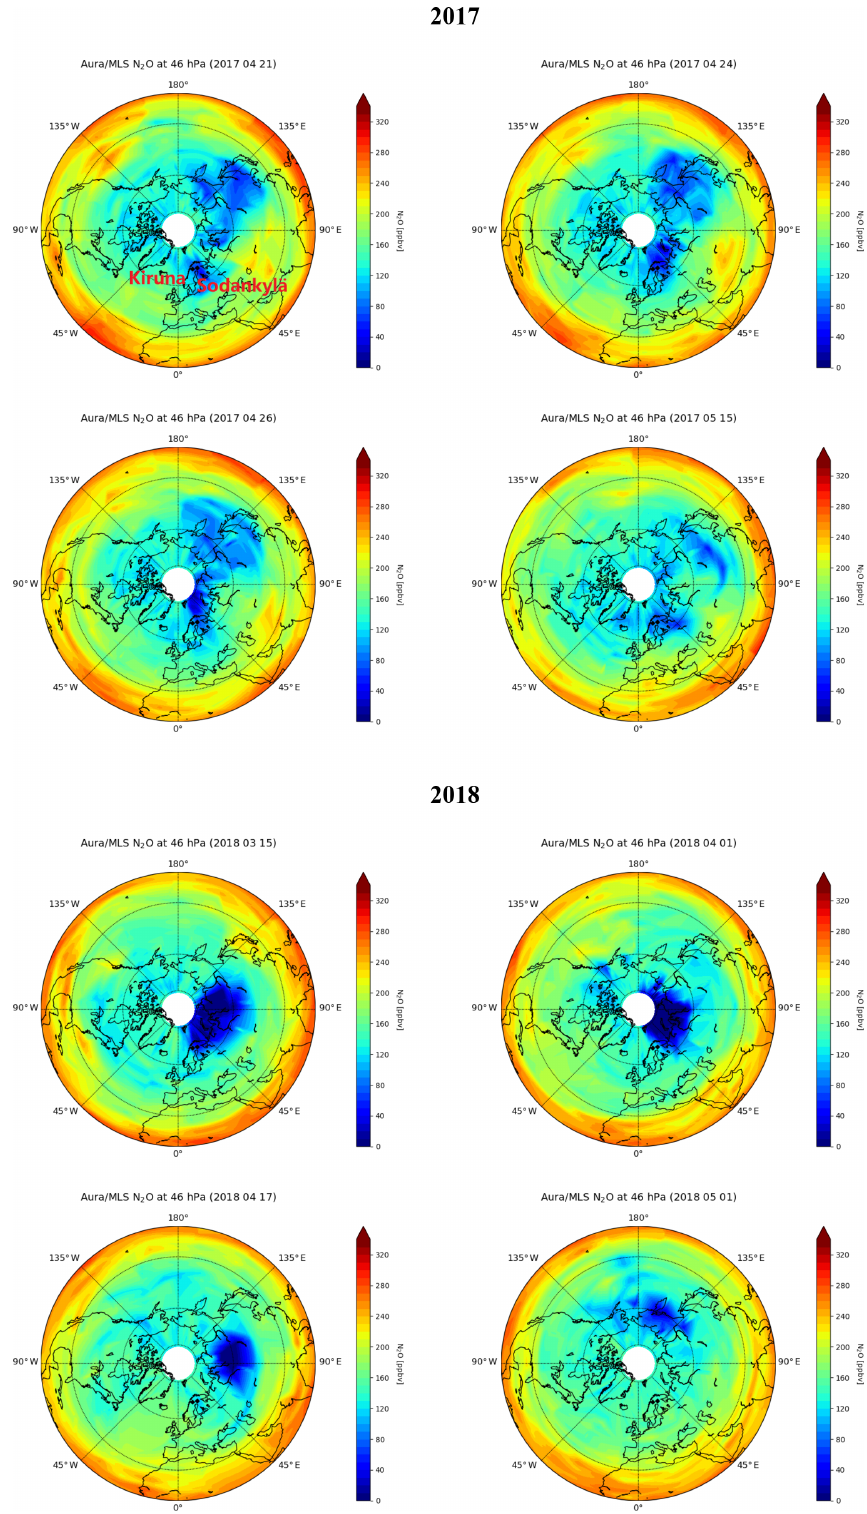
Figure 4. Development of polar vortex in 4d in April–May 2017 and 4d in March–May 2018, using N 2 O retrieved from the Aura/MLS satellite dataset as a tracer. The two sites are denoted with diamond symbols (left one for Kiruna and right one for Sodankylä) in each